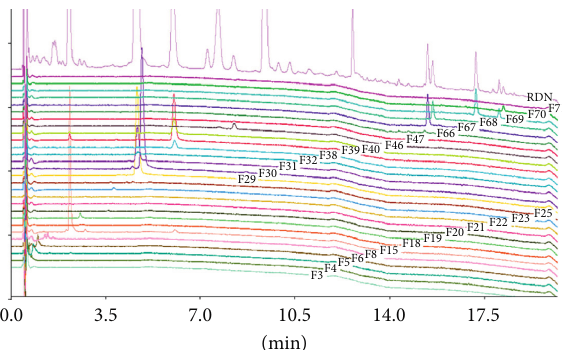
Figure 6: Comparing the chromatography of 28 potential active fractions with RDN